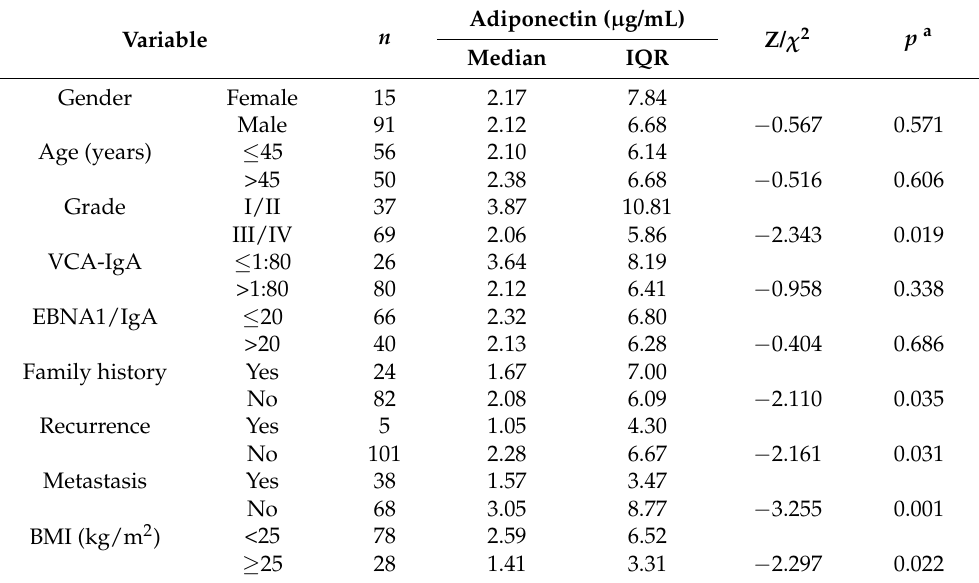
Table 1. Association between clinical characteristics and serum adiponectin levels in NPC